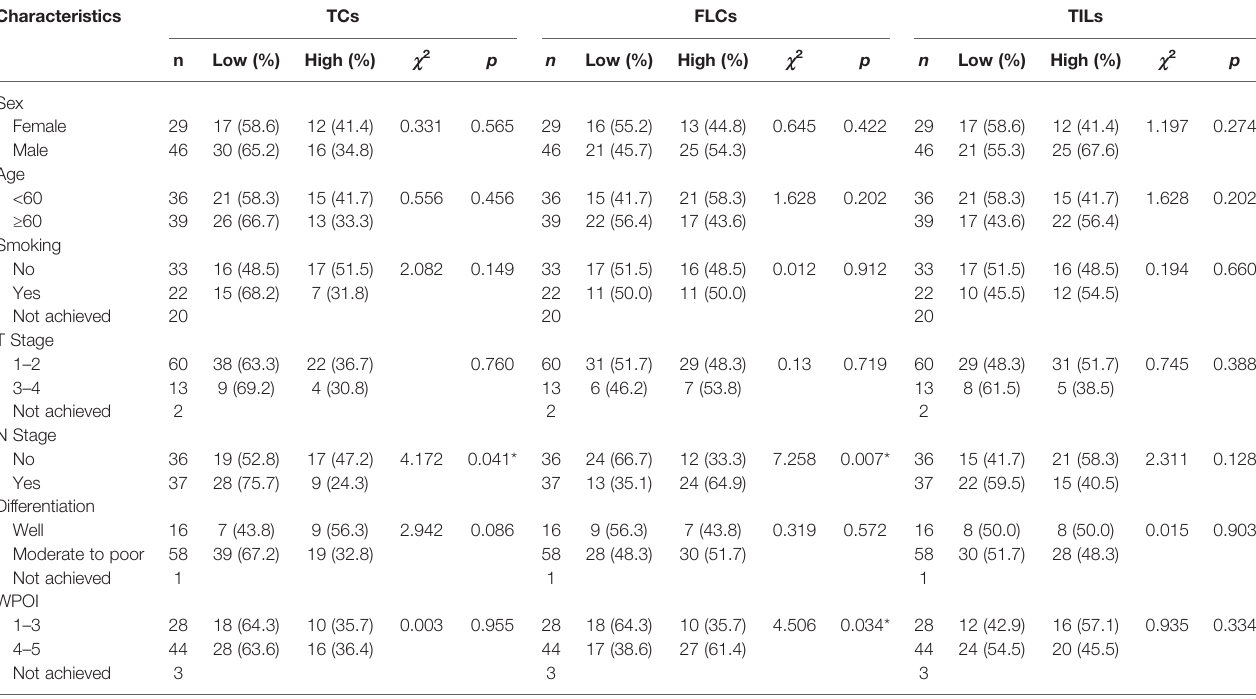
TABLE 1 | Association between Reelin and clinicopathological characteristics in OSCC patients.